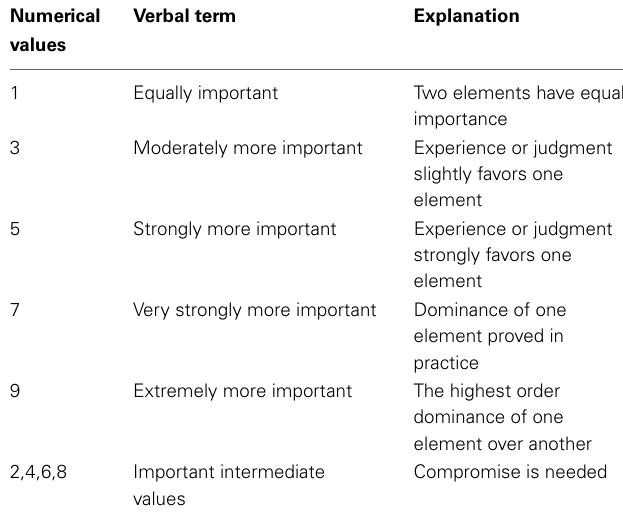
Table 1 | Fundamental Saaty’s Scale for pair-wise comparison (Saaty,